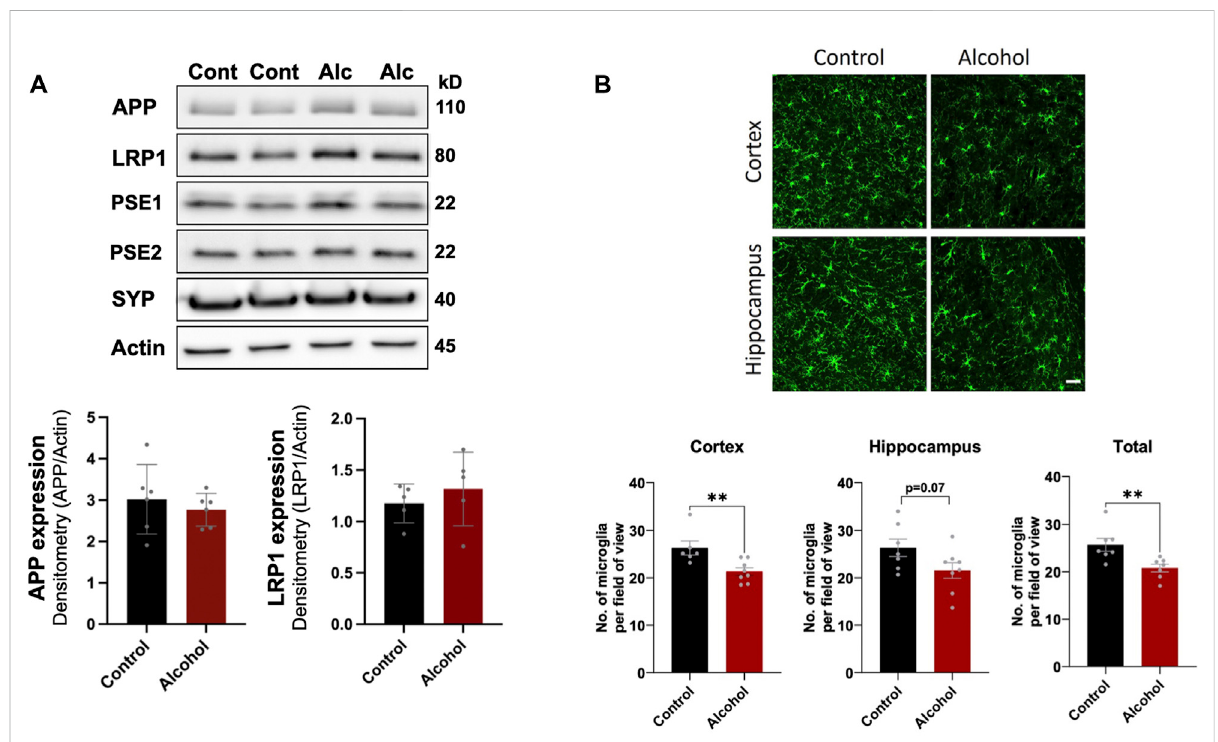
Effect of intragastric alcohol feeding on AD-relevant alterations in the brains of mice. (A) Expression of APP, PSE1, PSE2, LRP1, and synaptophysin(SYN), proteins thatare involved inA β synthesis, transport,andneuronalhealth,respectively, following4 weeksofintragastricalcohol feeding to mice. All immunoblots shown are representative samples from fi ve experiments. Densitometry for APP and LRP1 in the brain was performedusingNIHImageJ. β -actinwasusedastheloadingcontrol. (B) Microglialnumbers(Iba-1-stainedcells)inthebrainfollowing4 weeks ofintragastricalcoholfeeding.TheimagesshowIba-1-stainedcellsinthecortexandhippocampus(scalebarrepresents50 µm).EachIba-1-stained image was manually read to count the number of microglia per image using NIH ImageJ. For each brain region, the microglia counts were averaged to give the average number of microglia per region per mouse. n = 6 – 7 mice per group. Results are mean ± SD. ** p < 0.01. Original blots are presented in Supplementary